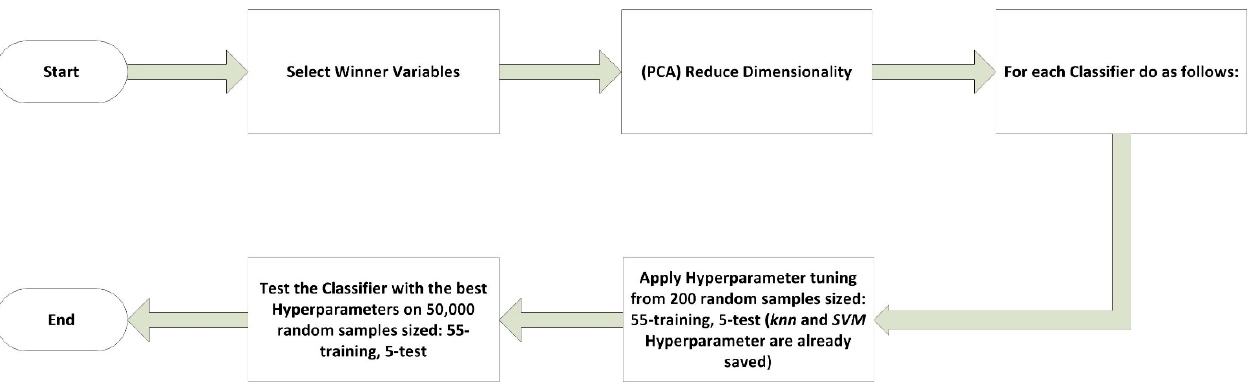
Figure 5. Methodology used with each of the 4 classifiers.